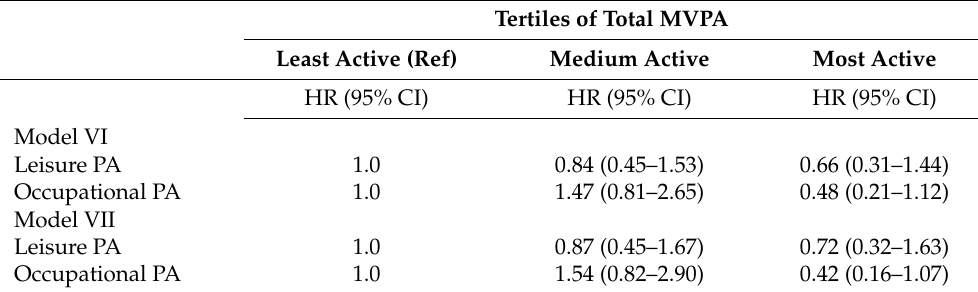
Table A1. Sensitivity analysis excluding individuals younger than 35 years at baseline, n = 582 and 57 events (Model VI), and sensitivity analysis excluding individuals with less than four days of accelerometer recordings or no weekend day, n = 714 and 50 events (Model